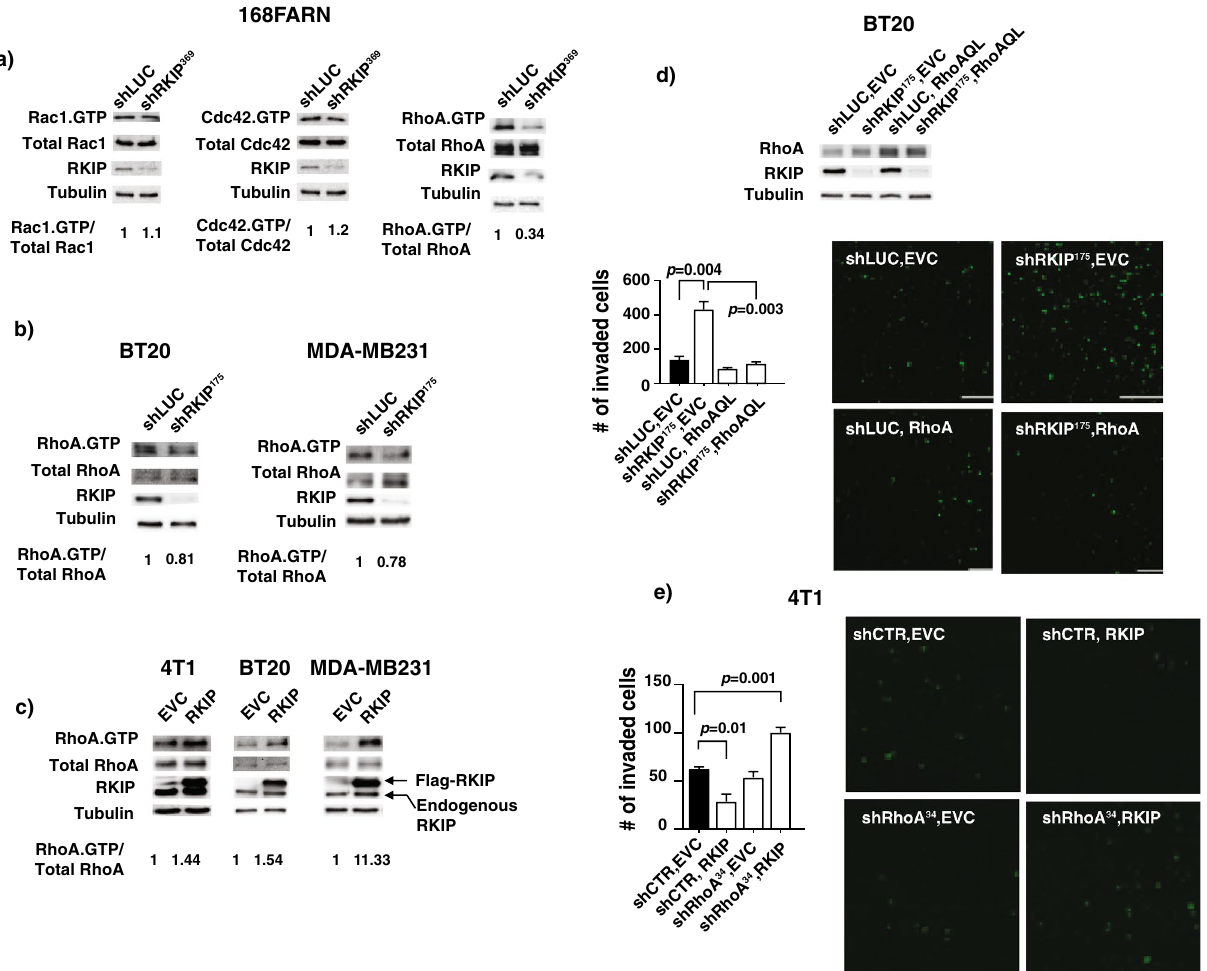
Figure 1. RKIP activates RhoA to suppress breast cancer cell invasion. ( a ) Representative western blots with the indicated Abs of GTPase pull-down assays with lysates prepared from control knockdown (shLUC) or RKIP knockdown (shRKIP 369 ) 168 FARN cells as indicated. Numbers are shown for quantified active GTPase bands normalized with total protein. ( b ) Representative western blots of GTPase pull-down assays with lysates prepared from control knockdown (shLUC) or RKIP knockdown (shRKIP 175 ) BT20 (left) and MDA-MB231 (right) cells as indicated. Numbers are shown for quantified active RhoA bands normalized with total protein. ( c ) Representative western blots of GTPase pull-down assays with lysates prepared from control (EVC) or RKIP expressing (RKIP) 4T1(left), BT20 (middle) and MDA-MB231 (right) as indicated. Numbers are shown for quantified active RhoA bands normalized with total protein. ( d ) (Top) Representative western blots of lysates prepared from BT20 cells with different combinations of controls, RKIP knockdown (shRKIP 175 ) and RhoAQL expression as indicated. (Left, bottom) Representative results of invasion assays with same set of cells showing number of invaded cells through Matrigel in each indicated BT20 cell lines (mean ± SE). (Right, bottom) Representative images of the stained invaded cells in indicated cell lines shown at the bottom left panel. ( e ) (Left) Number of invaded 4T1 cells with different combinations of controls, RhoA knockdown (shRhoA 34 ) and RKIP expression as indicated through Matrigel (mean ± SE). (Right) Representative images of the stained invaded cells in indicated cell lines shown in the left panel. Unpaired Student’s t-test (two-tailed) was used for all analyses with p < 0.05 considered